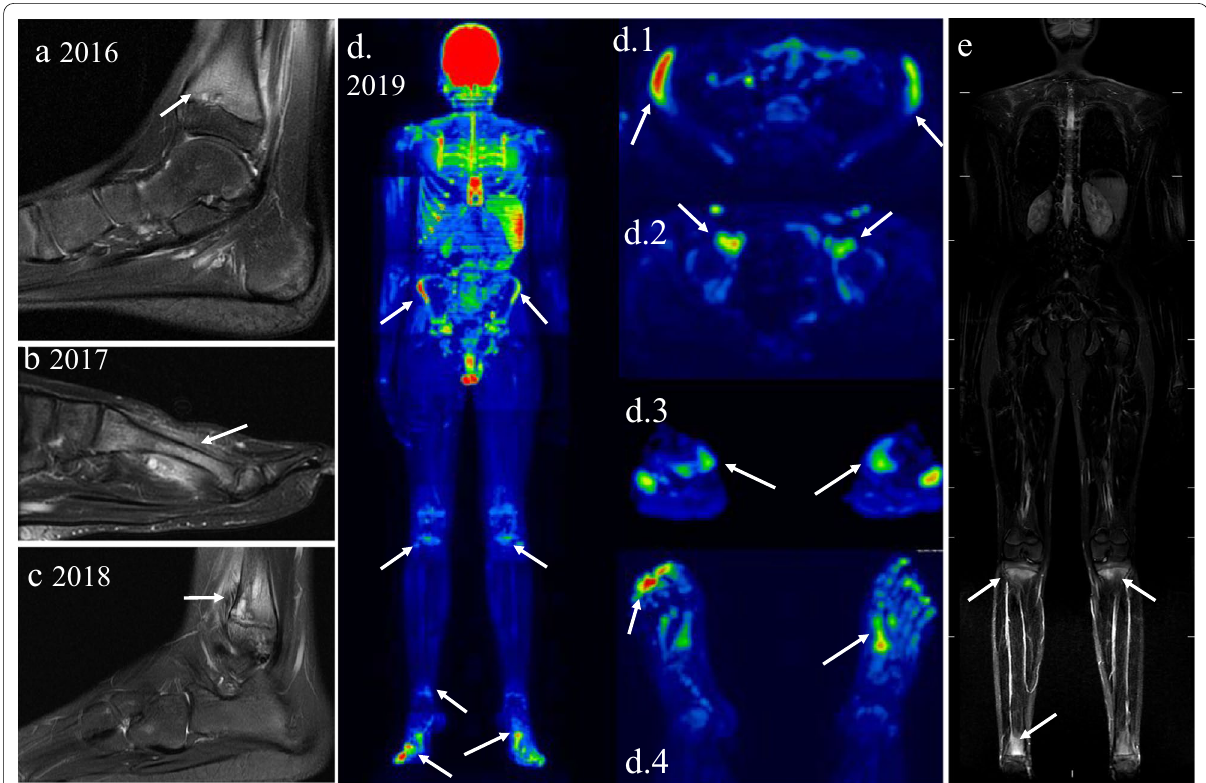
Fig. 12 A 10-year-old boy who complained of pain in his left ankle and presented with a metaphyseal lesion in the distal tibia ( a ) which was initially suspected of bacterial osteomyelitis, despite negative biopsy and culture. In 2017, a foot examination showed a lesion in the second metatarsal of the left foot ( b ) and in the following year, lesions in the distal fibula were detected ( c ), which led to the hypothesis of CNO. WB-MRI was then performed and showed multiple lesions dispersed throughout the skeleton, in typical bilateral locations, confirming the diagnosis of CNO. WB-MRI DWI ( d ) and STIR ( e ) detected involvement of the iliac bones (d.1), anterior acetabulum column (d.2), bilateral tibial proximal metaphysis (d.3) and bones of the metatarsus (d.4) in correspondence with the STIR sequence of the whole body ( e